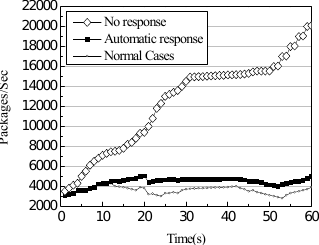
Fig. 2. The network flow comparison of three